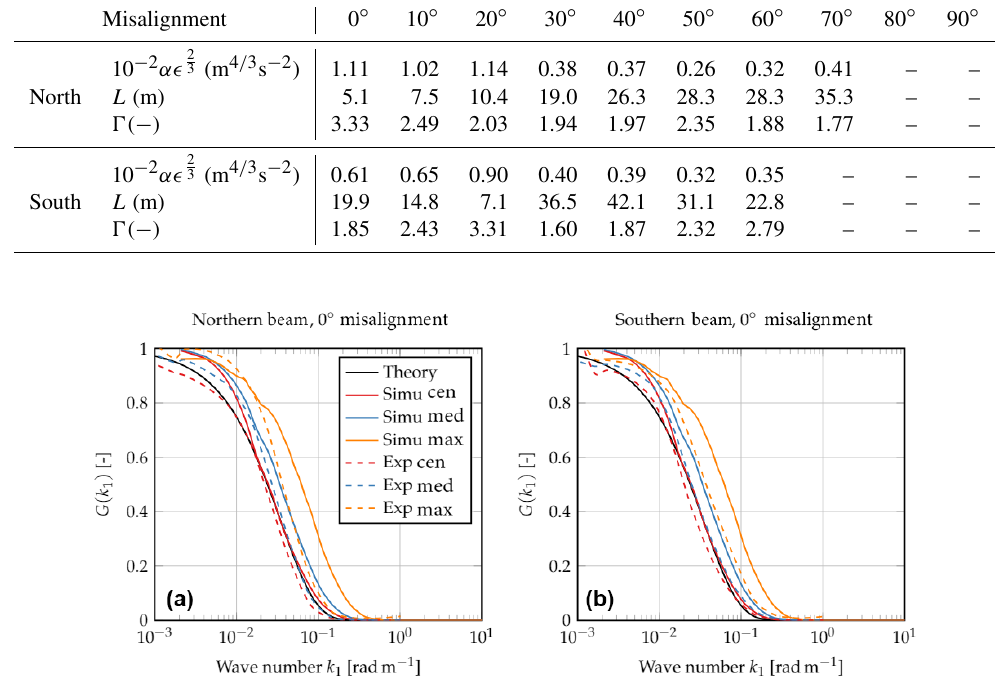
Figure 6. Transfer function G(k 1 ) for aligned beams for the northern beam data ( a ) and southern beam data ( b ) using 20 simulations and 2 months of experimental data at a sampling rate of